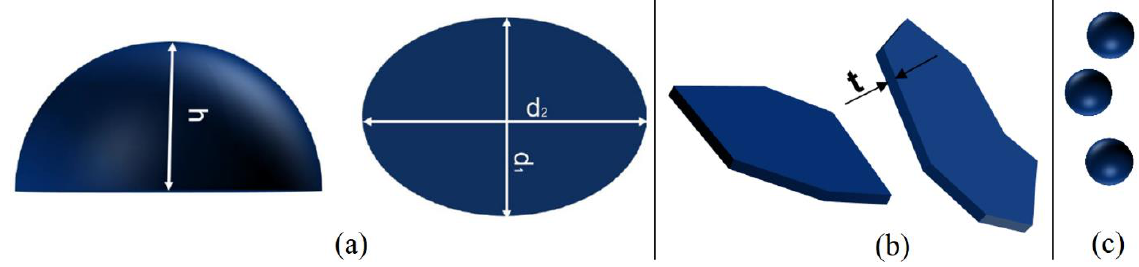
Figure 2. Schematic representation of ( a ) the lenticular virgin PP, ( b ) the irregularly shaped regrind PP and ( c ) the powdery PE.